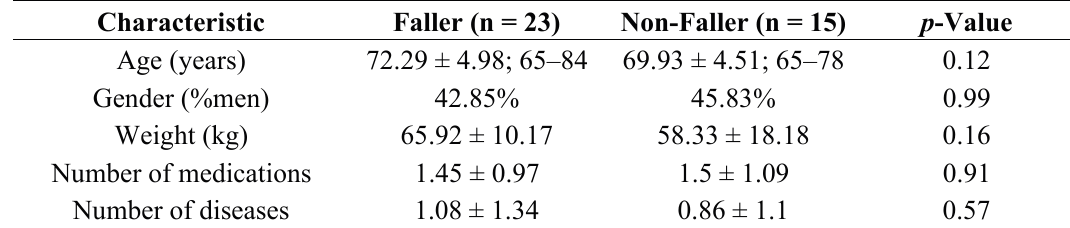
Table 2. Characteristics of the participants in both groups. Values are shown as MEAN ± SD (standard deviation) in two groups; p -values are based on t-tests comparing continuous data or chi-square tests comparing categorical